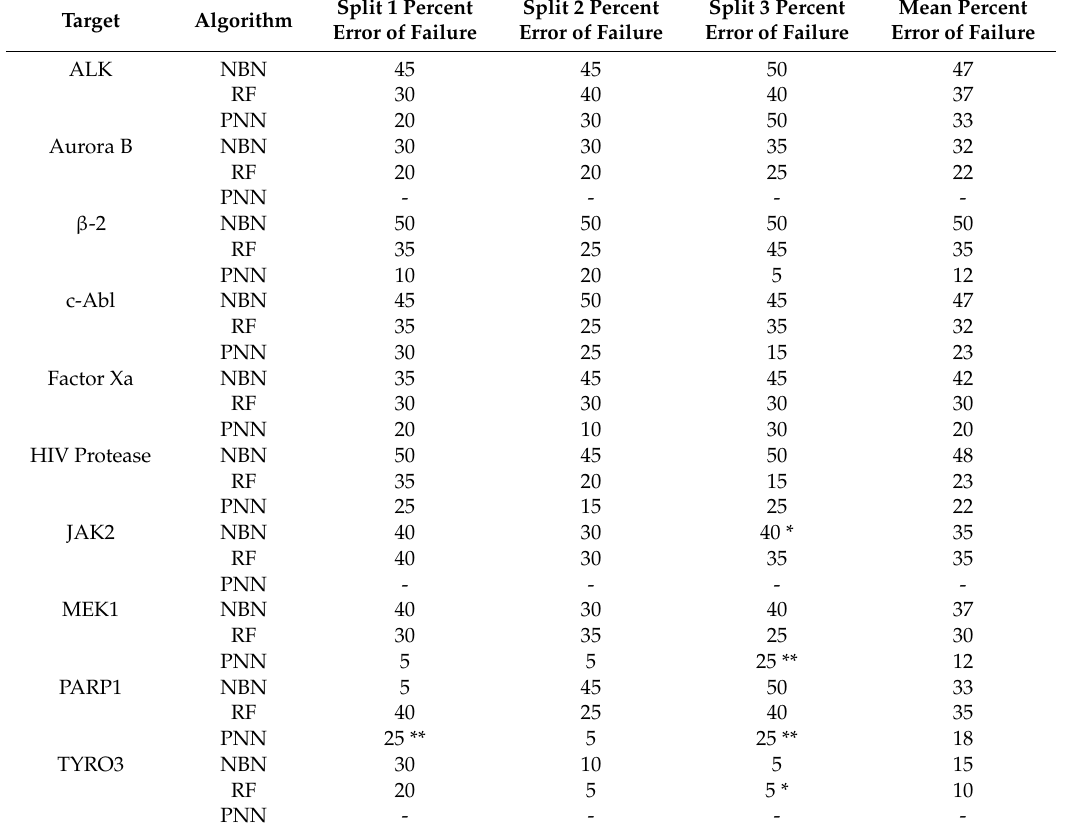
Table 9. Summary of points of failure for each algorithm, random split and target.